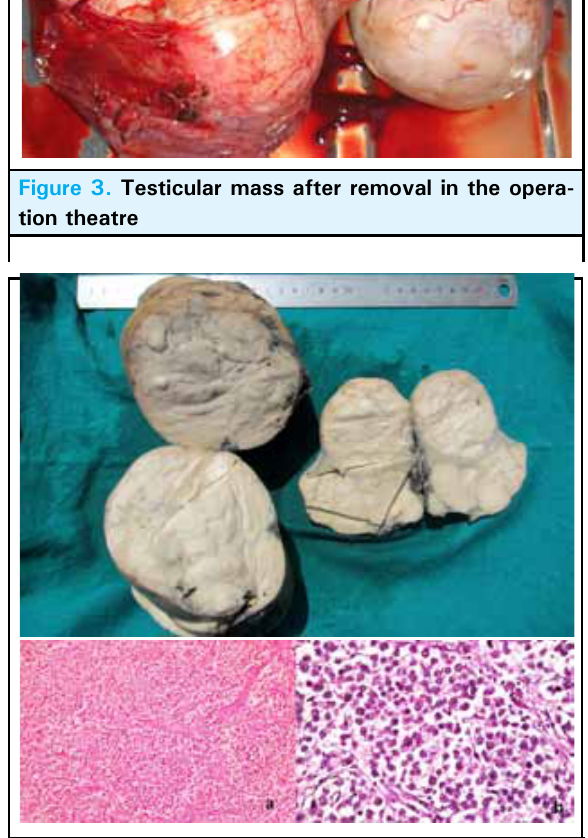
Figure 4. a) Microscopic picture showing seminoma cells separated by thin fibrous stroma. (H&Ex10). b) High power showing polygonal cells with clear cy - toplasma, round nucleus and inconspicuous nucleoli